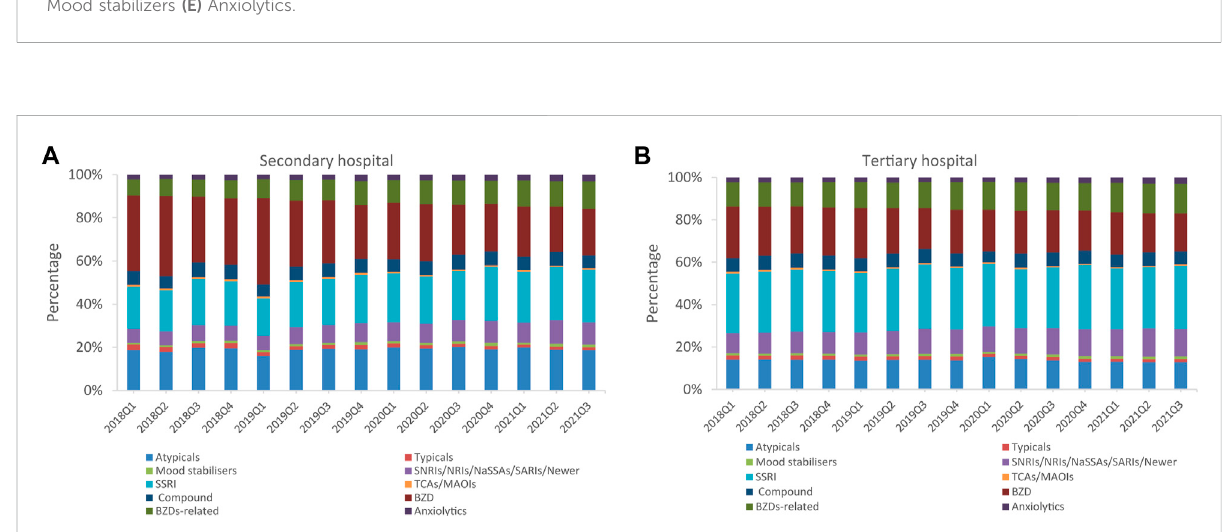
FIGURE 5 Psychotropic utilization in each subclass (A) Secondary hospitals (B) Tertiary